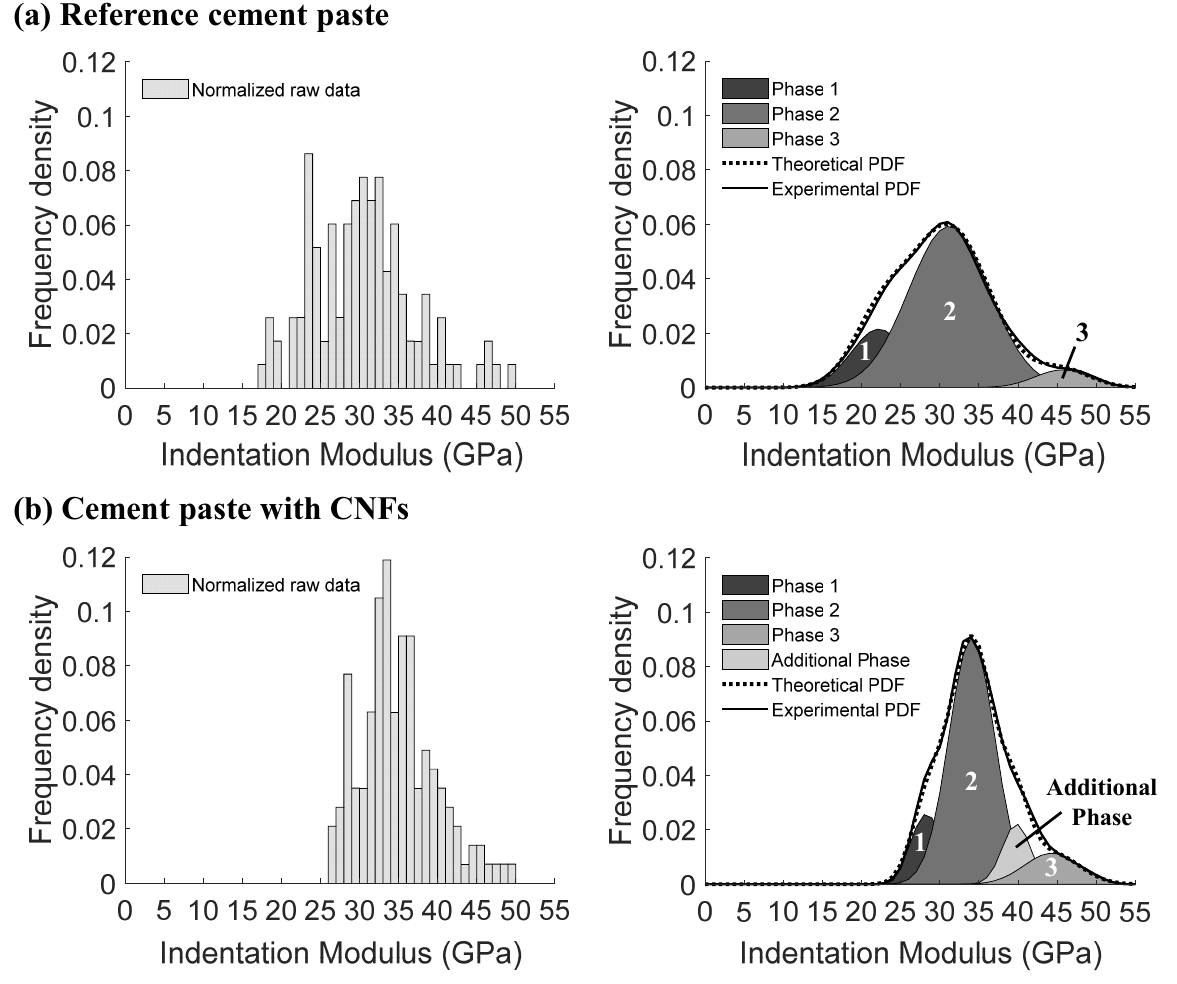
Figure 9. Normalized histogram of the raw data ( left ) and multimodal Gaussian fitting results ( right ) for the 0 to 50 GPa range of the indentation modulus typically associated with C–S–H phases for the ( a ) reference cement paste and ( b ) cement paste with CNFs. Table 3. Output from the Gaussian fitting algorithm for the 0–50 GPa indentation modulus range of the phases typically associated with C–S–H phases for the reference cement paste and cement paste with CNFs.